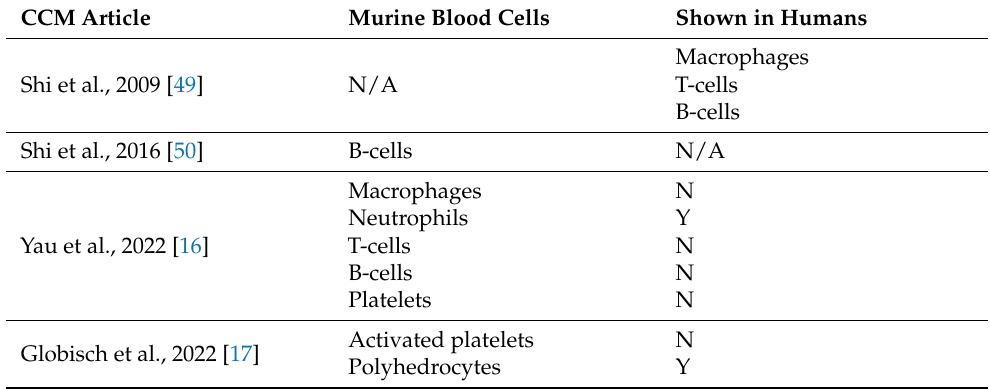
Table 2. Blood cells identified in